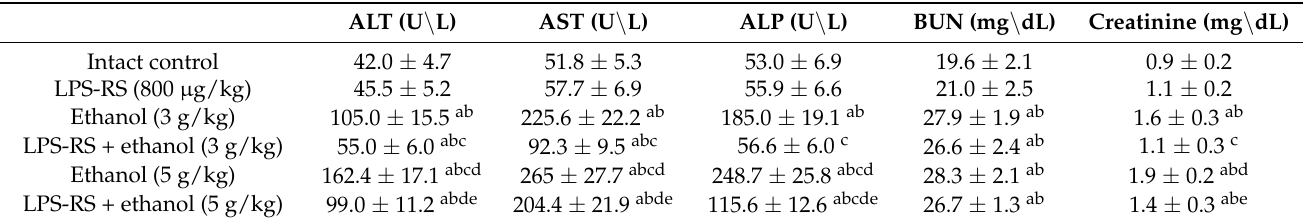
Table 1. The effect of LPS-RS (800 µ g/kg) on serum levels of liver enzymes and kidney function markers in the experimental rats.